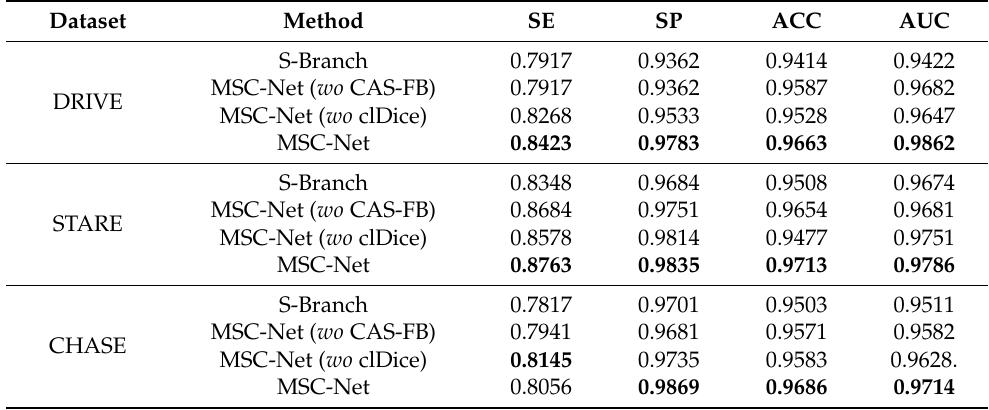
Table 5. Ablation experiments of the influence of different modules on vessel segmentation.